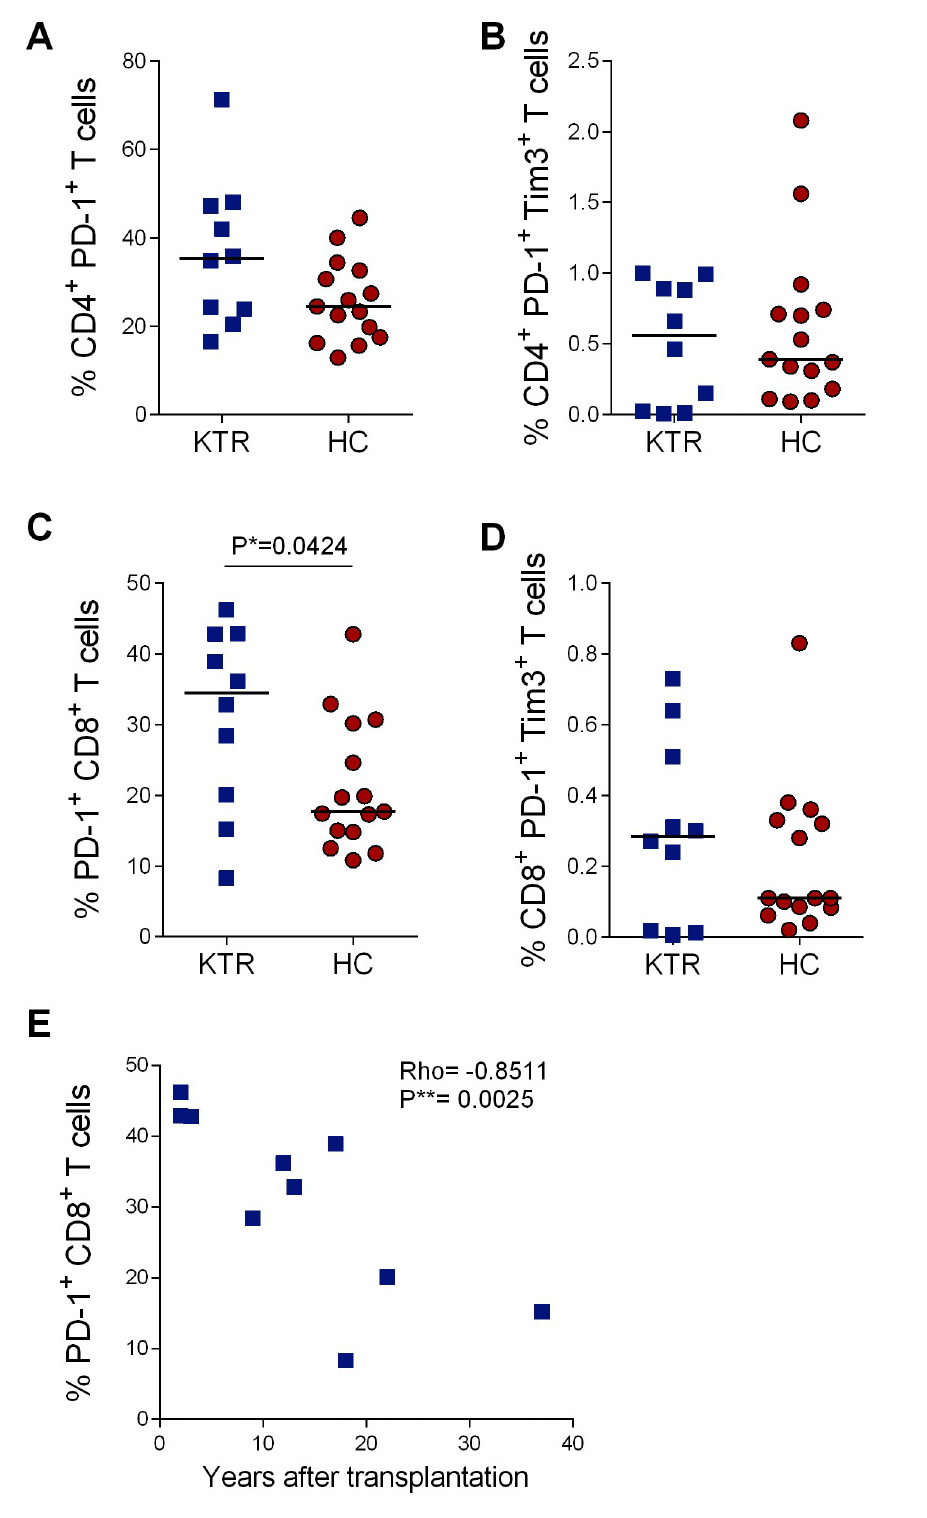
Fig 4. T cell activation/exhaustion phenotype during kidney transplantation. PD-1 and Tim-3 expression on A) CD4 + and B) CD8 + peripheral blood total T cells. Data are shown for 10 kidney transplant recipients (KTRs) and